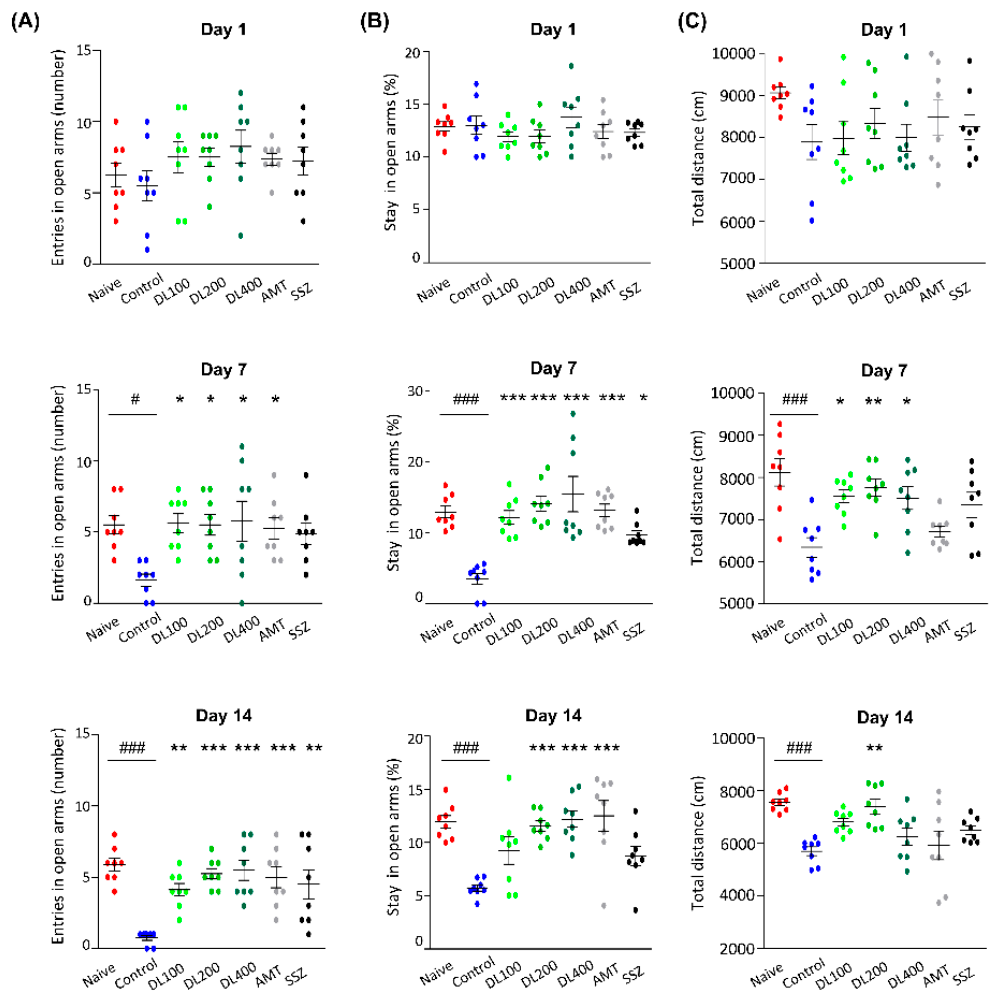
Figure 6. Effects of DL on anxiety-related behaviors in the EPM test and OFT. ( A ) The number of entries, ( B ) percentage of relative stay in open arms, and ( C ) travel distance in the OFT were measured on days 1, 7, and 14. Data are presented as a mean ± standard deviation ( n = 8, one-way analysis of variance; # p < 0.05, ### p < 0.001 vs. naïve; * p < 0.05, ** p < 0.01, *** p < 0.001 vs. control). DL, D. lablab L. extracts; AMT, amitriptyline; SSZ, sulfasalazine; EPM, elevated plus maze test; OFT, open field